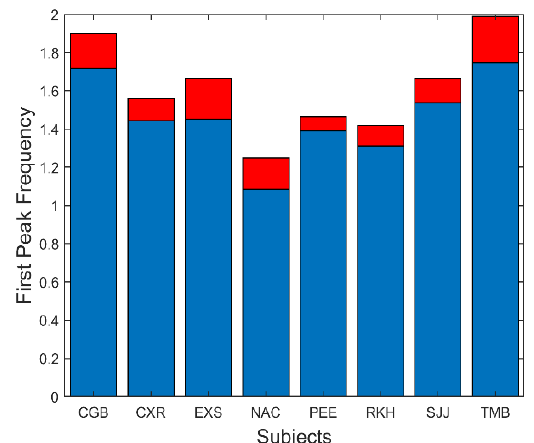
Figure 9: Slow component oscillations had a fundamental frequency that varied between approximately 1.1 and 1.8 Hz. Mean is plotted in blue and standard deviations is plotted in red.